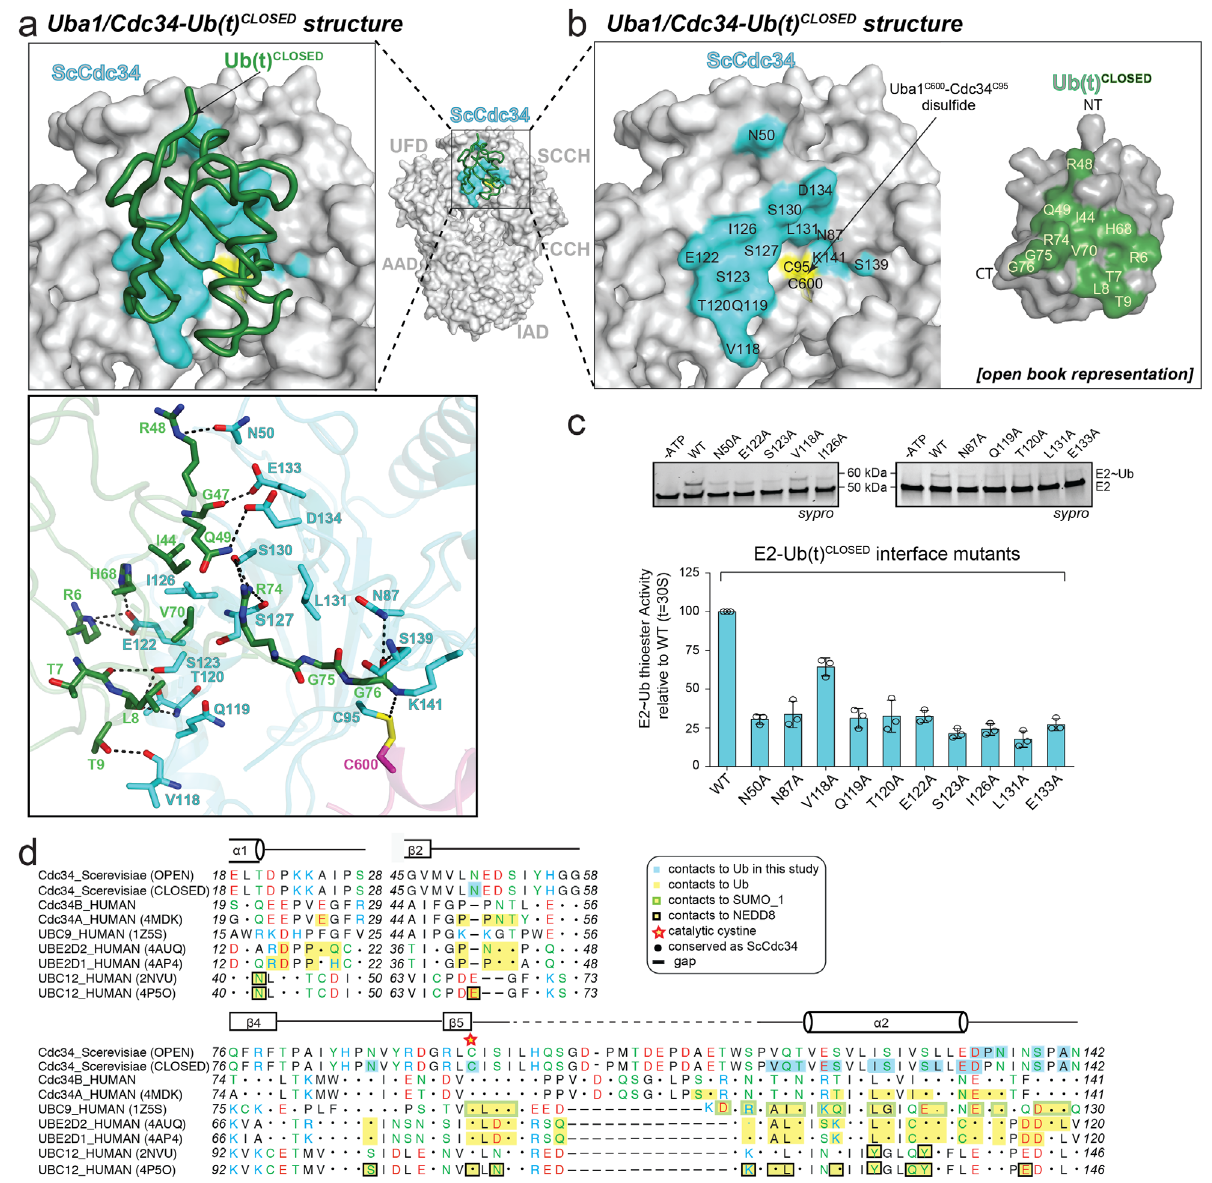
Fig. 4 Interfaces of Uba1/Cdc34 A141K – Ub(t) CLOSED structure. a Top, Uba1/Cdc34 A141K -Ub(t) CLOSED structure with surfaces of Uba1 domains and Cdc34 gray with only contacting residues colored. Ub(t) is represented as loop and colored green. Bottom, Network of contacts between Cdc34 and Ub(t) with involved residues shown as sticks with red oxygen atoms, blue nitrogen atoms, and yellow sulfur atoms. Hydrogen bonds are indicated by dashed lines. b Surface representations of Uba1, Cdc34, and Ub(t) shown in open book representation with residues in the interface colored cyan (E2) and green (Ub(t)). c E1 – E2 thioester transfer assays of the indicated mutants for Cdc34. Data are represented by mean ± SD with three independent technical replicates labeled above and individual replicates shown as black circles. Gel images are representative of independent technical replicates ( n = 3). Source data are provided as a Source Data fi le. d Sequence alignment of E2s across different species with Cdc34 ’ s secondary structure cartoon shown above sequence. Shaded boxes indicate E2s residues that interact with the Ub(t), Nedd8 or (Figs. 2, 4, Supplementary Fig. 5b). At the center of this interface, the central hydrophobic network, Gln49 of Ub(t) CLOSED engages Leu8, Ile44, His68, and Val70 from the Ile44 hydrophobic patch in polar contacts to Ser130 of Cdc34 and Arg74 from the C - of Ub(t) CLOSED engages in a network of van der Waals interac- terminus of Ub(t) CLOSED engages in hydrogen bonds to the tions with Ile126, Ser127, and Ser130 of Cdc34. This central backbone carbonyl oxygen of Ser127 and the side-chain hydroxyl network of hydrophobic interactions is surrounded on either side of Ser130. by networks of predominantly hydrogen-bond mediated inter- Mutations at this interface including N50A, N87A, Q119A, actions. On one side, the backbone carbonyl oxygens of Thr7, T120A, E122A, S123A, I126A, L131A, and E133A result in a Leu8, and Thr9 from Ub(t) CLOSED engage in hydrogen bonds to signi fi cant decrease in Uba1 – Cdc34-Ub transthioesteri fi cation Cdc34 Val118, Thr120, and Ser123 and His68 and Lys6 (K6R) activity suggesting an important role for this interface in catalysis engage in hydrogen bonds to Cdc34 Glu122. On the other side of that will be discussed in more detail below (Fig. 4a – c;